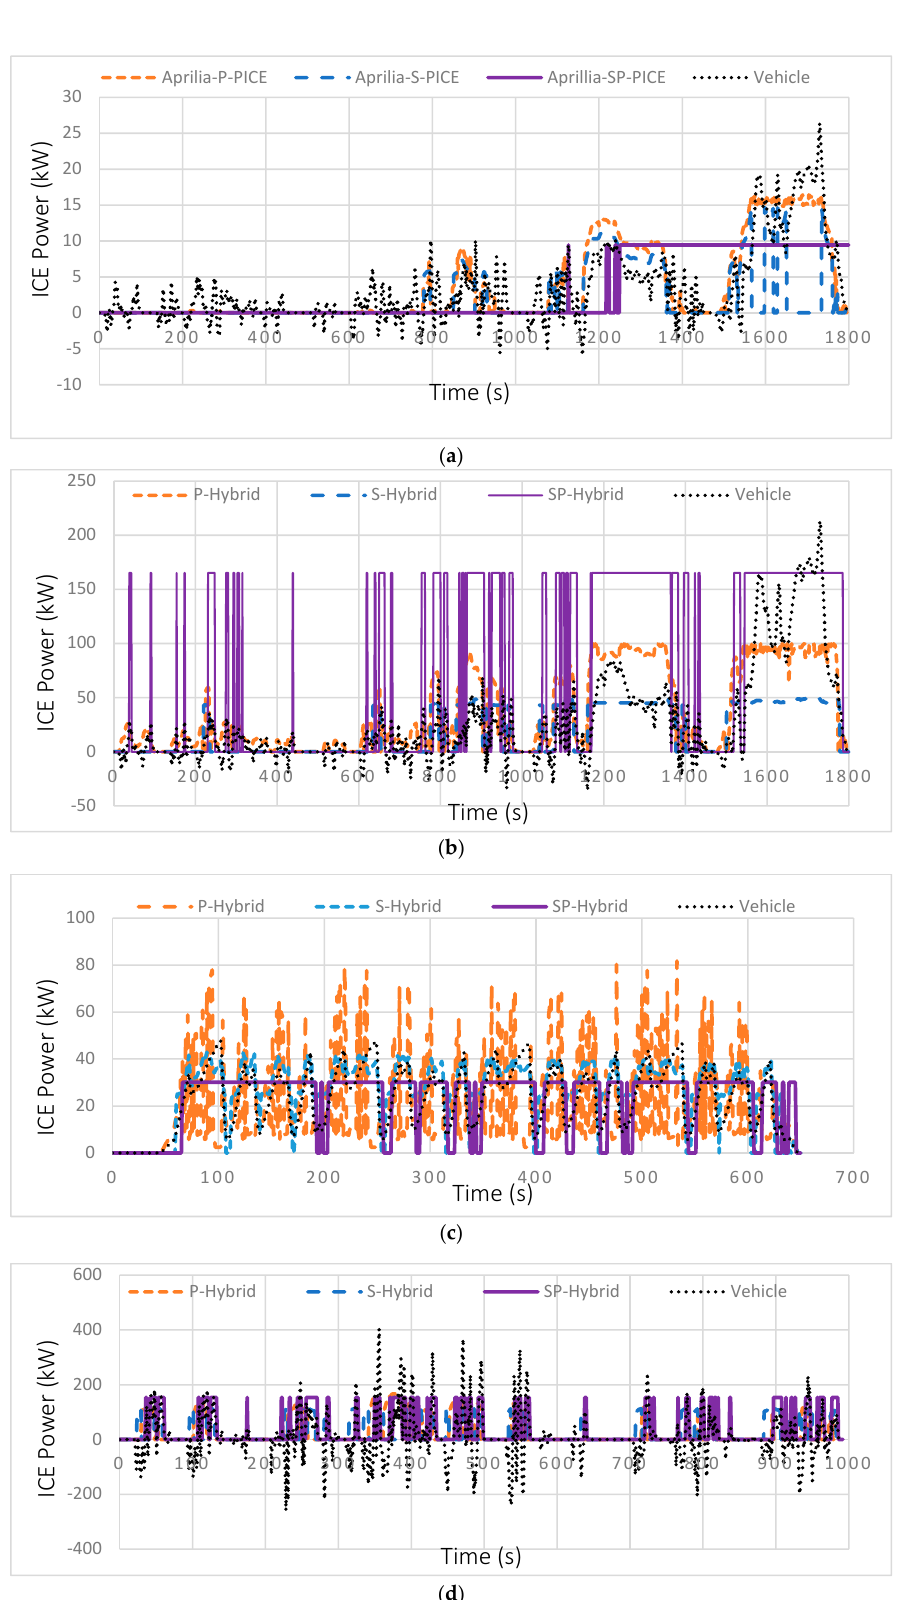
Figure 15. ICE power distribution for three architectures: ( a ) Aprillia in WLTP driving-cycle; ( b ) CT6 in WLTP driving-cycle; ( c ) Noao in Race way driving-cycle; and ( d ) K9 in Artemis Urban driving-cycle.